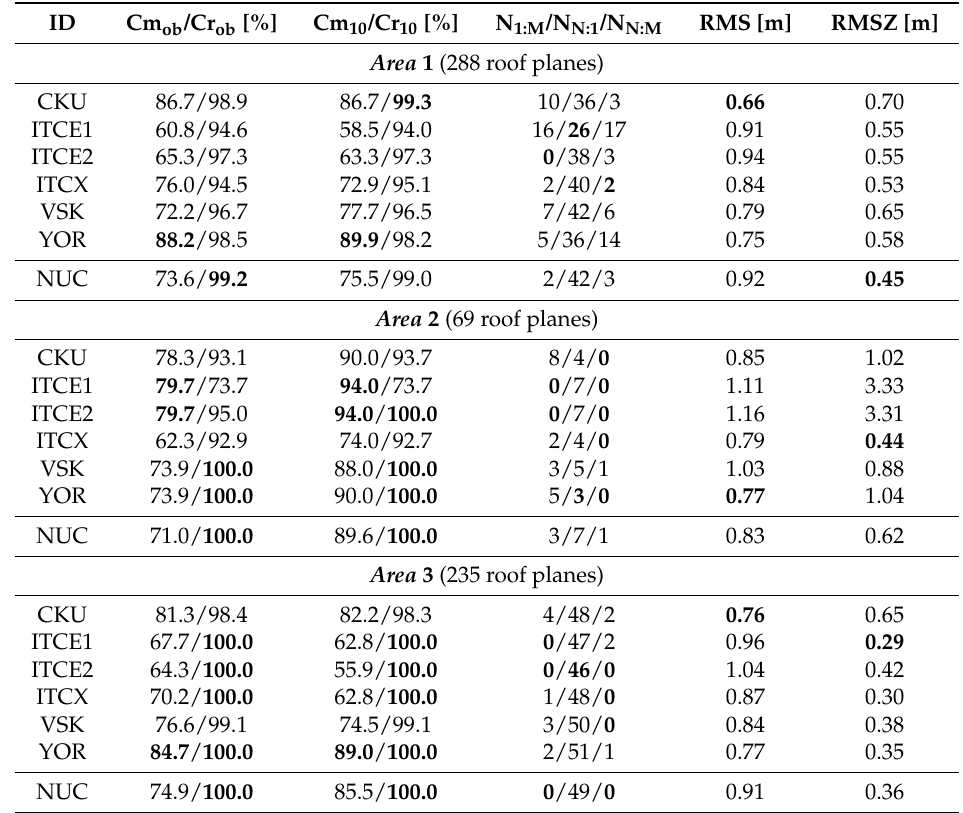
Table 5. Evaluation of building reconstruction results in Areas 1, 2, and 3. The best values per column are printed in bold